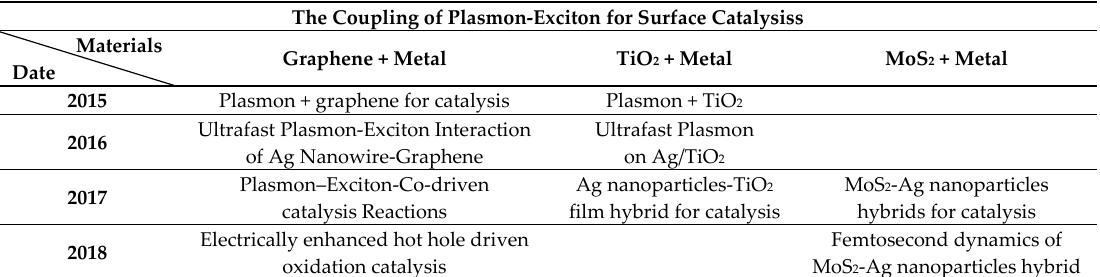
Table 1. The table demonstrates results of plasmon–exciton coupling for catalysis. The Coupling of Plasmon-Exciton for Surface